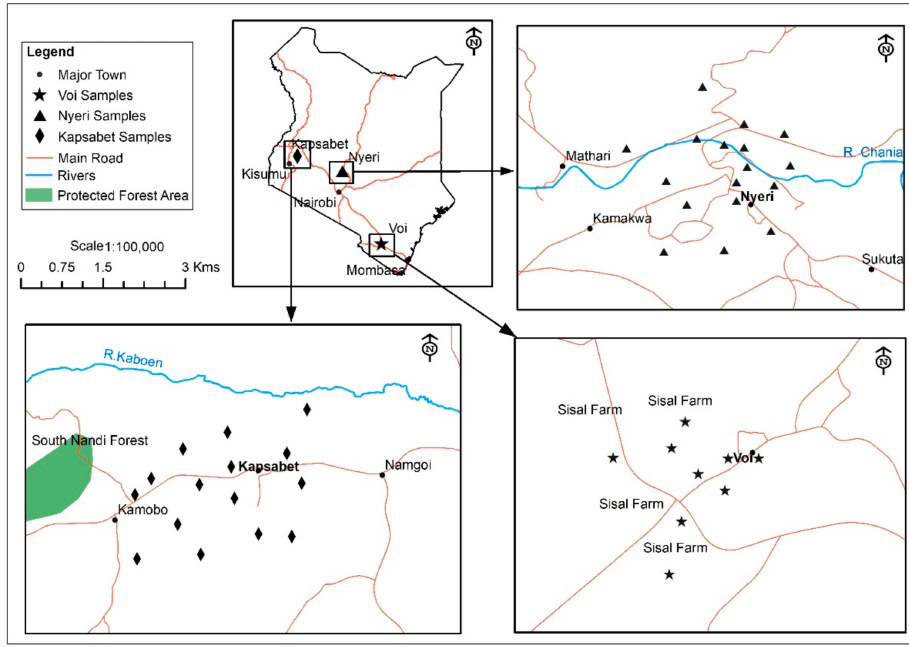
Figure 1. Map illustrating the location of sampling areas; Nyeri town in central highlands province, Kapsabet in Rift valley province, and Voi town in coast